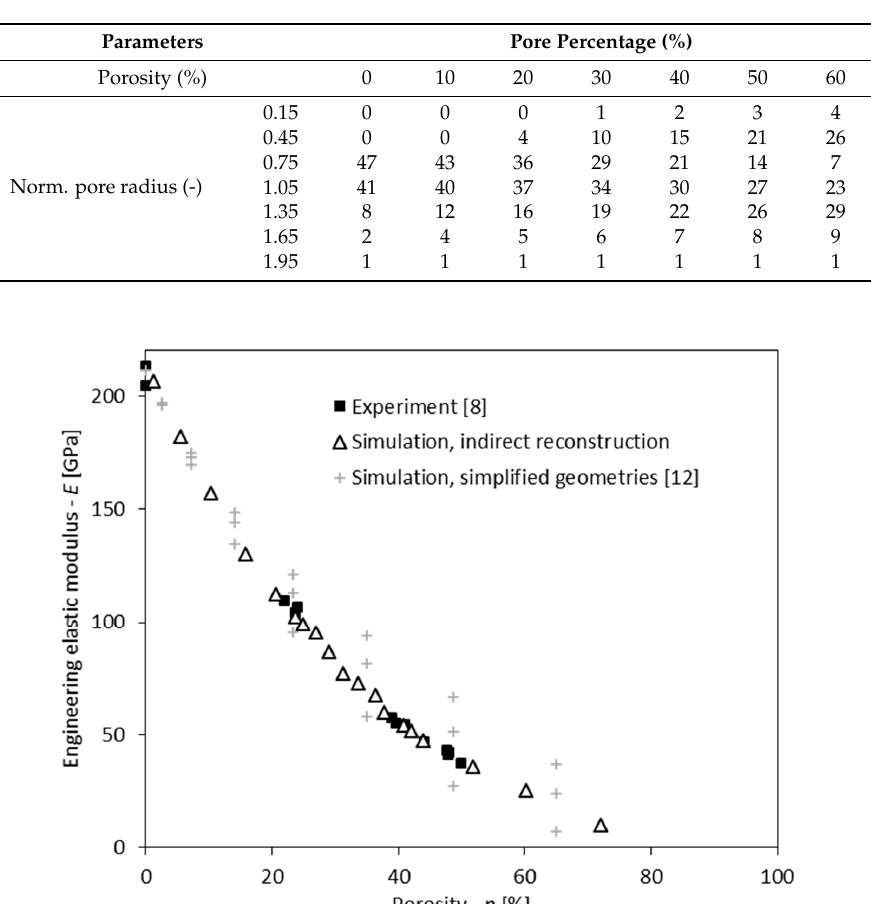
Figure 6. The dependency of engineering elastic modulus in transversal direction to pores on porosity in lotus-type iron: comparison of experimental measurements [8] with simulation results for indirectly reconstructed geometries and simplified geometries [12]. Table 3. The engineering elastic modulus of lotus-type iron in transversal direction to pores, obtained computationally with indirect model reconstruction.